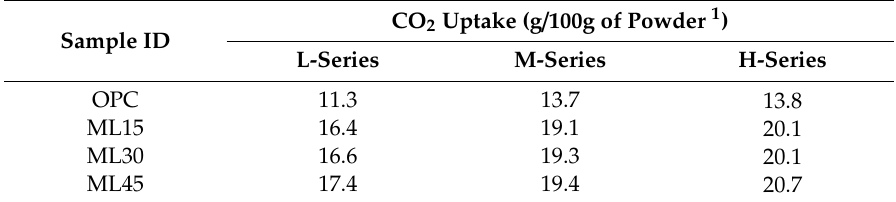
Figure 6. Thermogravimetry analysis curves of ( a ) W-, ( b ) L-, ( c ) M-, and ( d ) H-series samples. Table 4. CO 2 uptake capacity of the carbonated samples